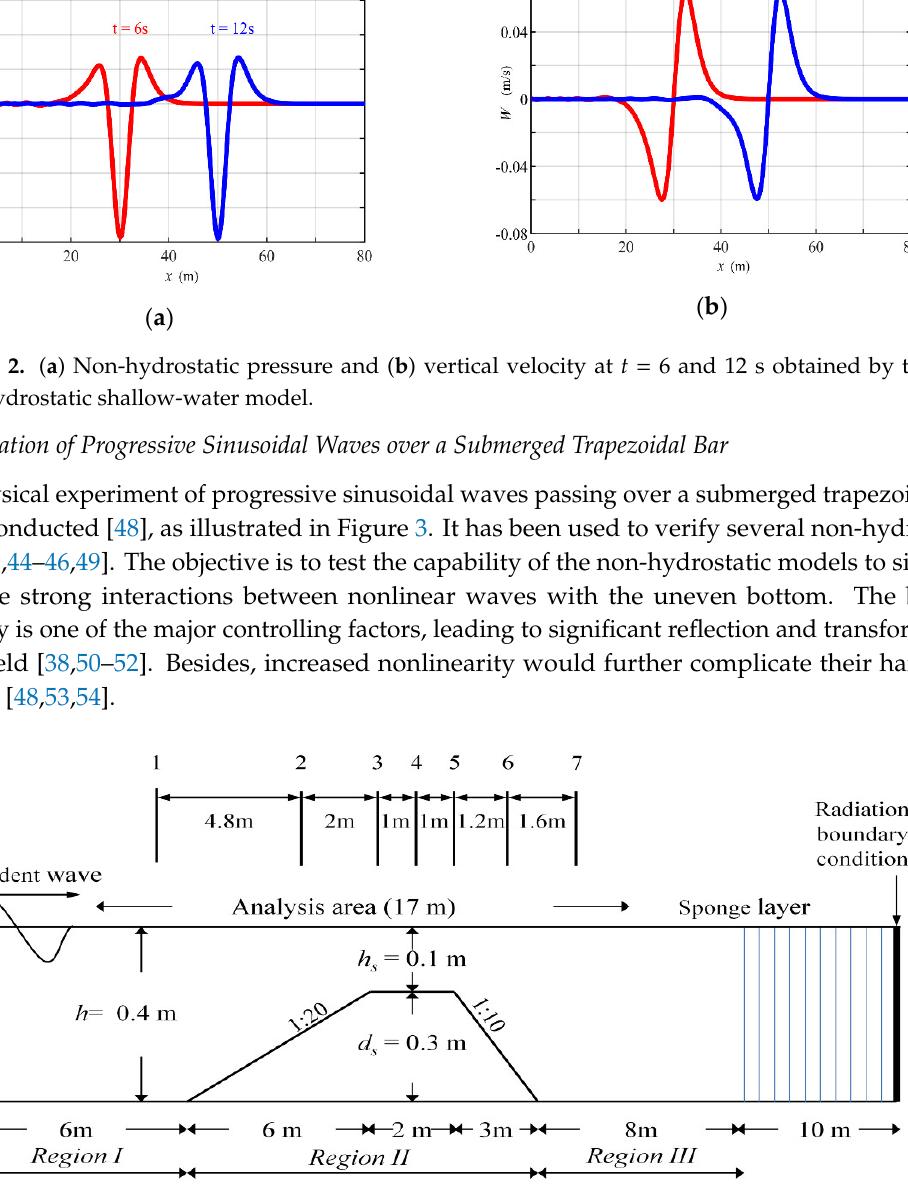
Figure 2. ( a ) Non-hydrostatic pressure and ( b ) vertical velocity at t = 6 and 12 s obtained by the non- hydrostatic shallow-water model.